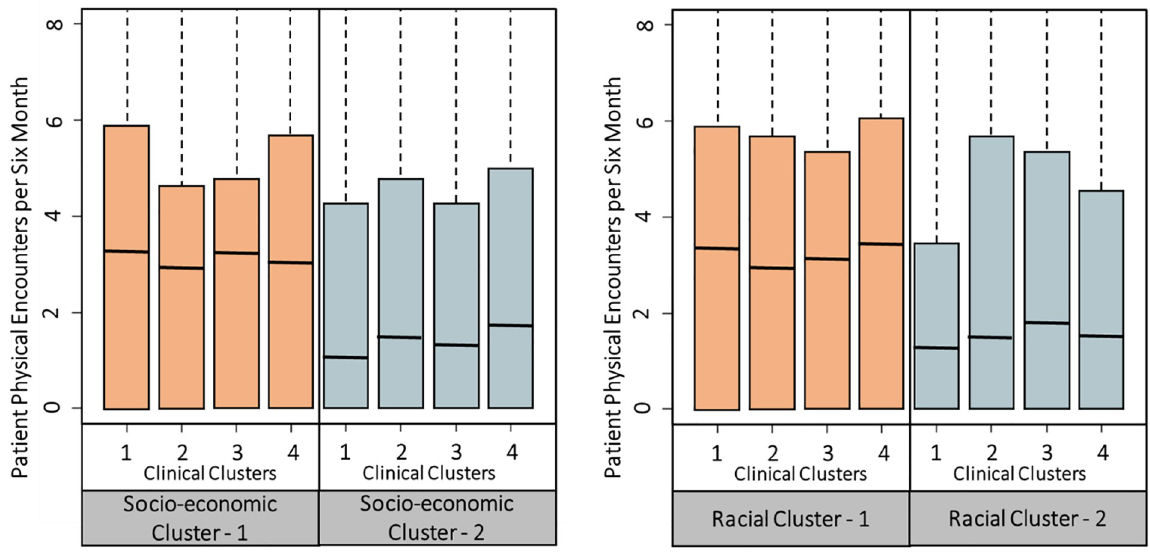
socioeconomic Cluster-2 have fewer physical encounters. In other words, after controlling for patients’ clinical status, patients who live in a ZIP-code with lower income and education level exhibit fewer physical encounters for diabetes treatment. The right panel in Fig 1 shows the distribution of physical encounters by different clinical clusters and racial clusters. Patients in the same clinical cluster have fewer physical encounters when they belong to Racial Cluster-2 (with lower white percentage and higher African American percentage). These results clearly indicate potential inequalities in patient encounters across ZIP-codes with varying sociodemo- graphic characteristics, after controlling for patients’ clinical status.